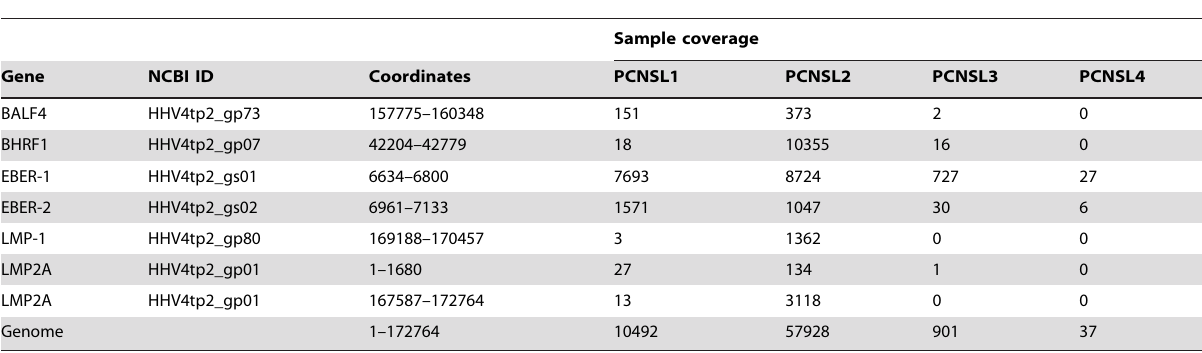
Table 3. Read coverage over select EBV genes for PCNSL